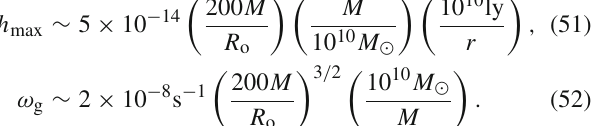
Fig. 4 A plot of R ( f ) for the special case with ( 0 , 0 , − K ) for a millisecond pulsar with τ